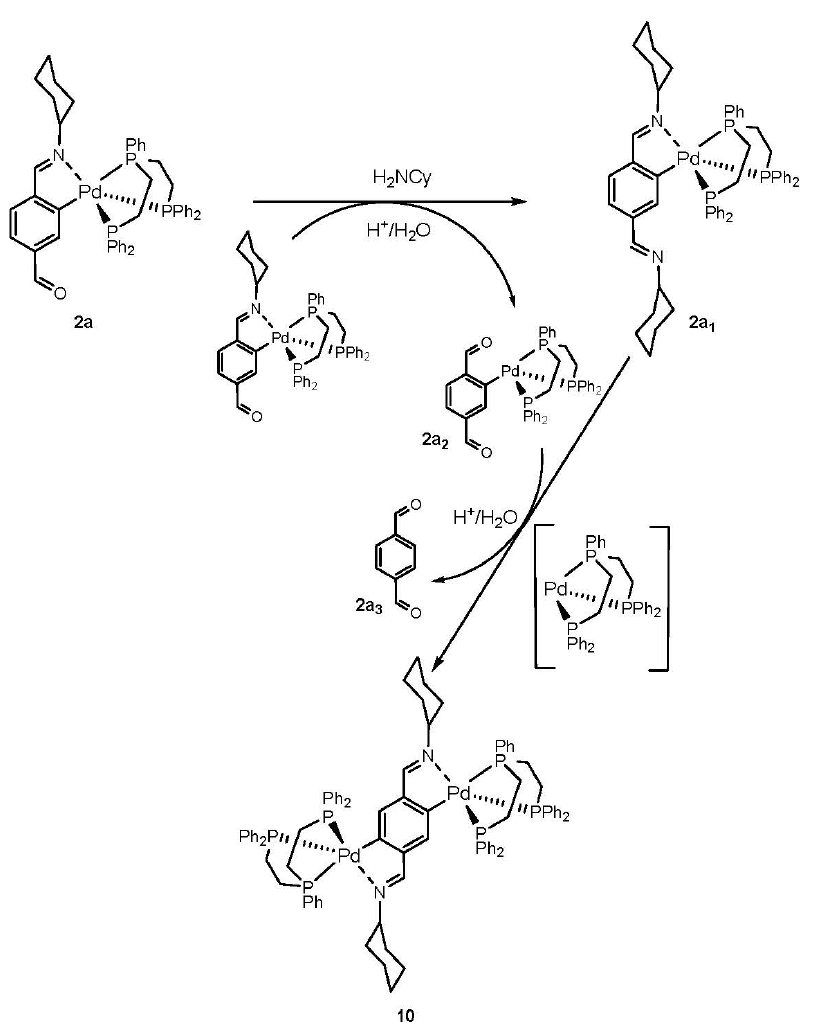
Figure 4. 31 P NMR plot for the 2a → 10 shift at room temperature. Compound 2a , red circles; compound 10 , blue circles.